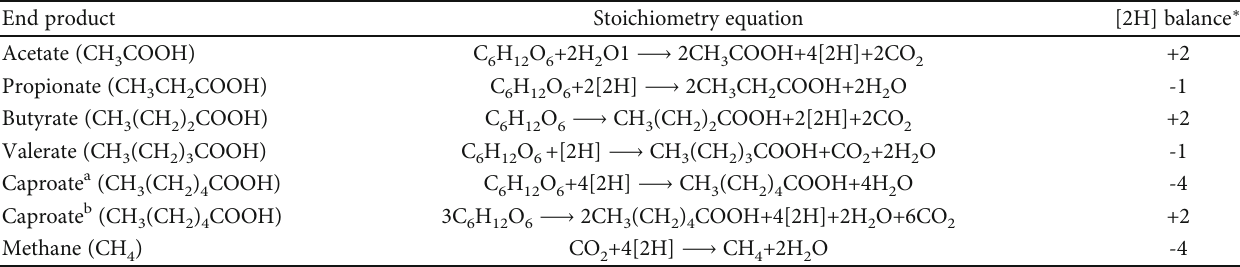
Table 1: Stoichiometric production and utilization of metabolic [2H] during synthesis of major end products of